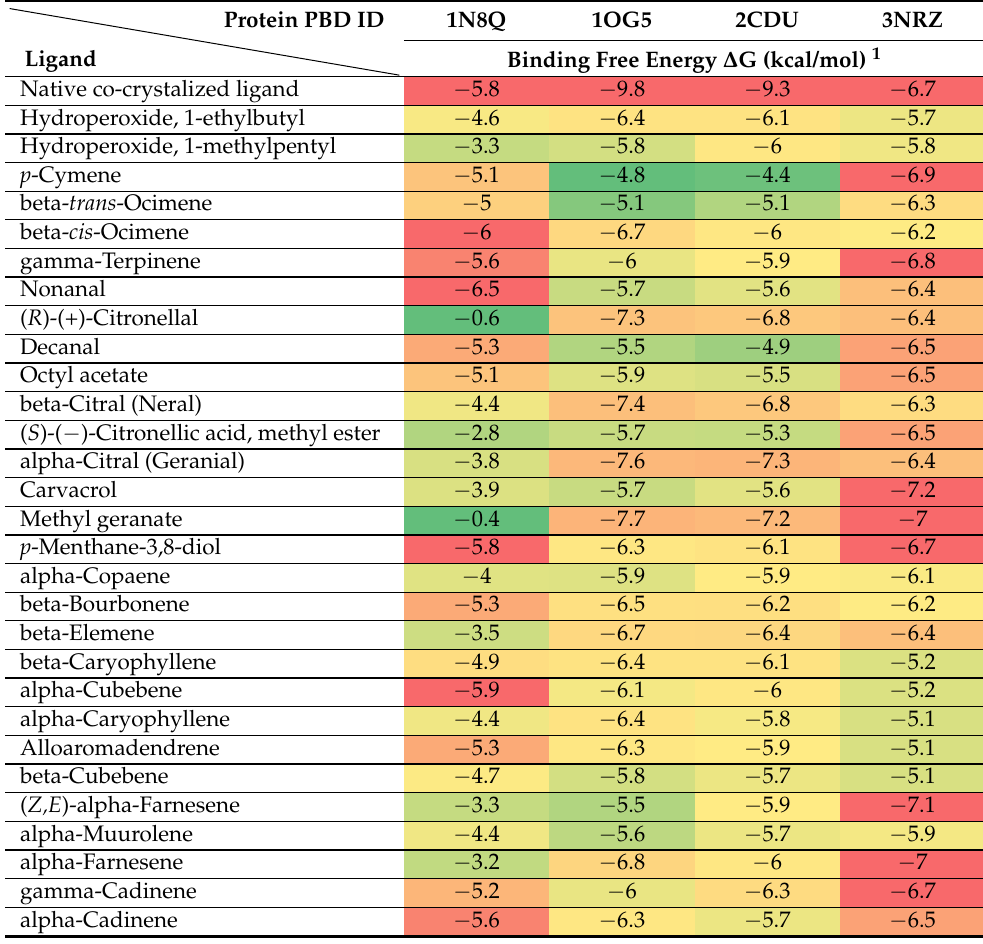
Table 4. Heat map of recorded docking scores (binding free energy—kcal/mol) of the M . officinalis subsp. officinalis essential oil